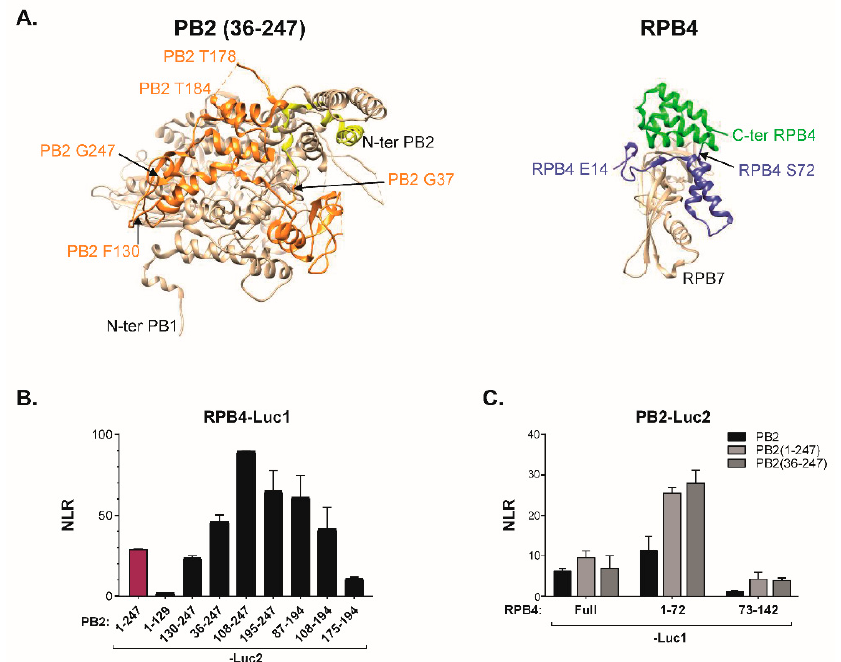
Figure 5. Identification of the PB2 and RPB4 amino acids stretches involved in the FluPol-RPB4 interaction. ( A ) Structures of the 36 − 247 domain of PB2 with the PB1 adjacent domain (PDB ID: 6QPF) and of the RPB4/RPB7 dimer (PDB ID: 2C35). ( B , C ) Split-luciferase complementation assay. ( B ) Luc2-tagged stretches of PB2(1 − 247) and Luc1-RPB4 were co-transfected into HEK293T cells. 24 h after transfection, cells were lysed and luminescence was measured. ( C ) The Luc1-tagged N- or C-moieties of RPB4 were co-expressed with the Luc2-tagged PB2 subunit or with N-ter derived forms of PB2 into HEK293T cells. After cell lysis, luminescence was measured and NLR calculated as in Figure 1B. Data are mean ± s.d. n = two technical replicates representative of three independents assays.